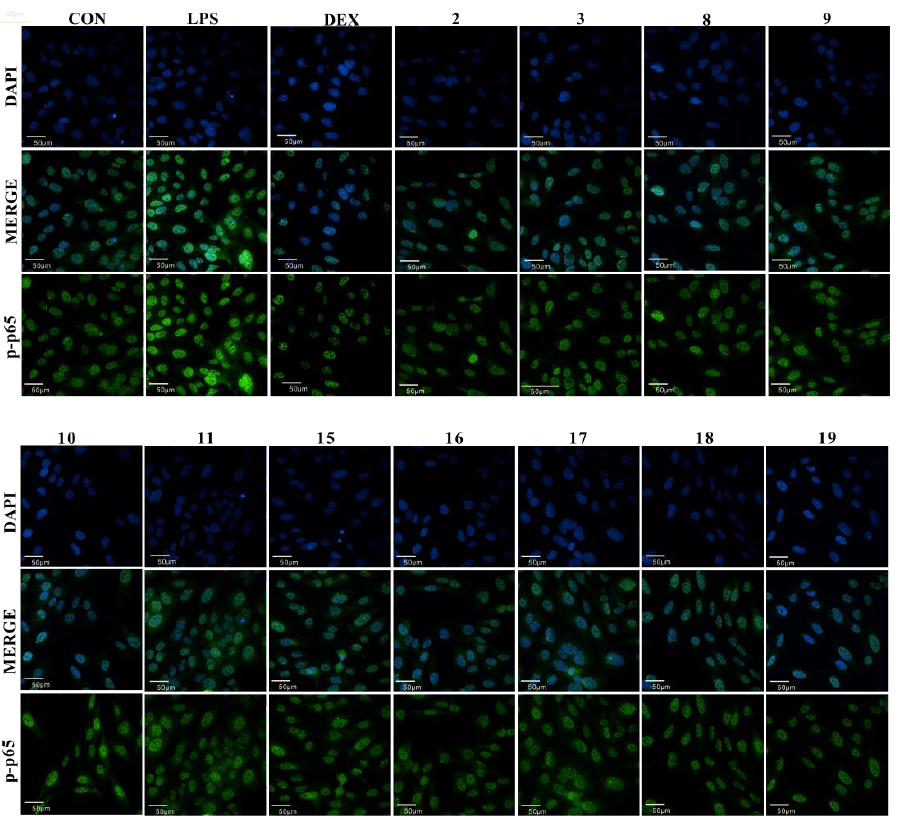
Figure 3. The effect of compounds 2 – 3 , 8 – 11 , and 15 – 19 on NF-KB p-p65 protein expression level of BEAS-2B. (Scale bars: 50 µ m. Three independent experiments were performed, and the data were expressed as the mean ± SD.). Table 2. The protective effect of compounds 1 – 25 on BEAS-2B cell injury induced by LPS.